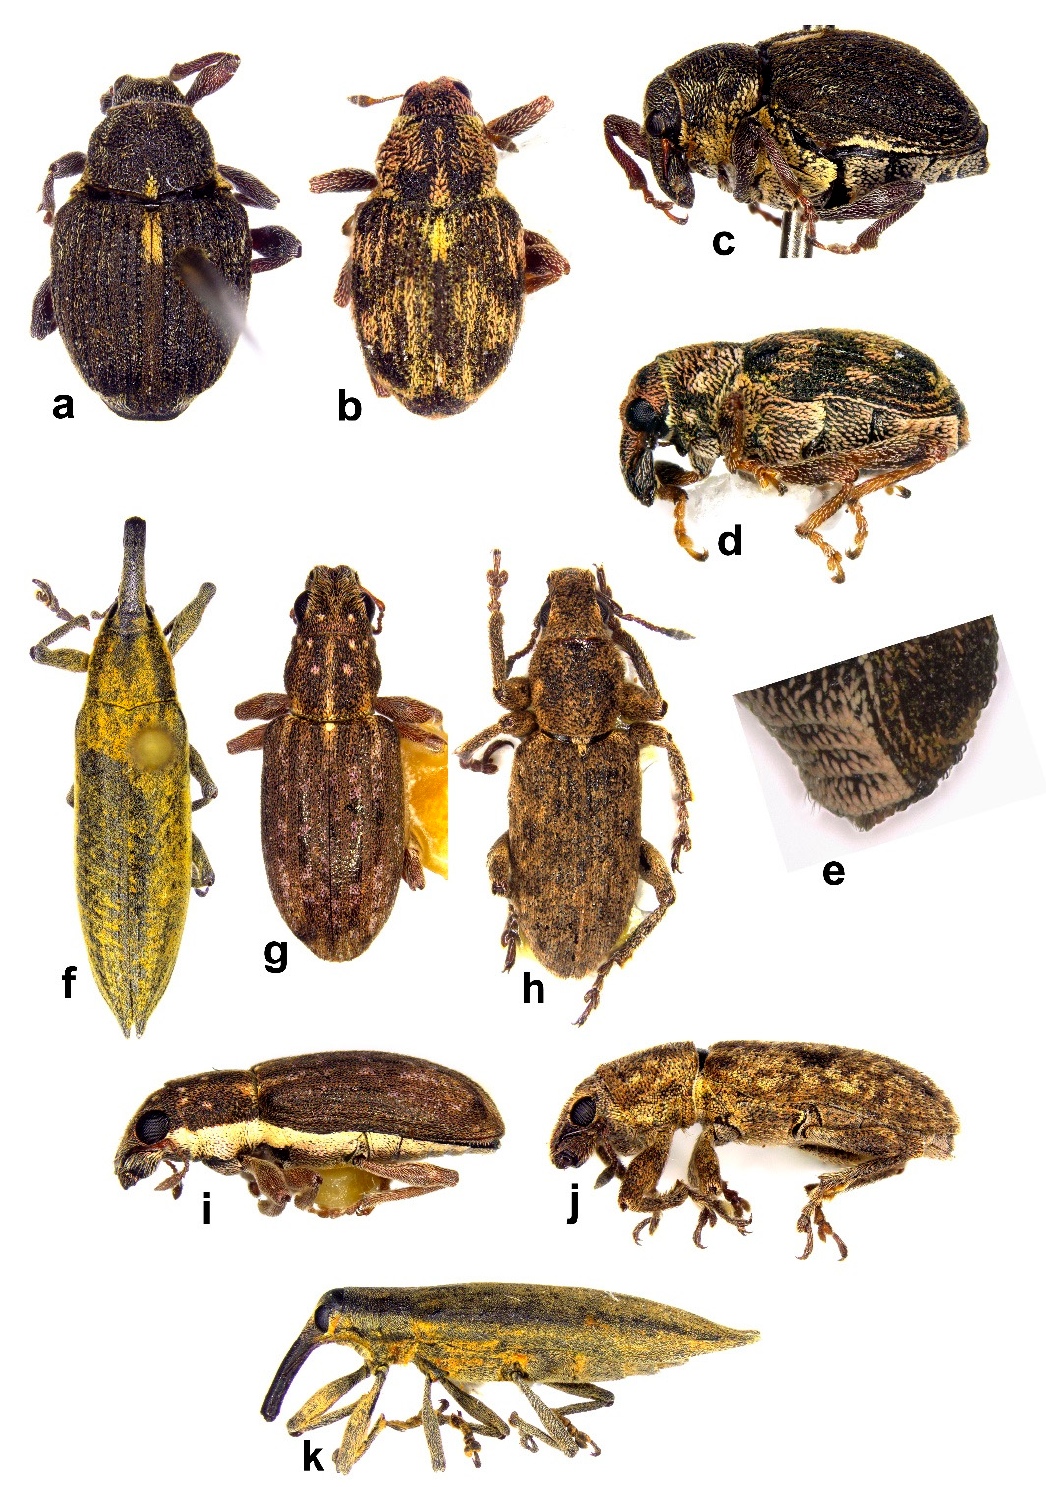
Figure 12. Habitus ( a ) Rhinoncus pericarpius , male, dorsal view; ( b ) R. perpendicularis , male, dorsal view; ( c ) R. pericarpius , male, lateral view; ( d ) R. perpendicularis , male, lateral view; ( e ) R. perpendicularis , male, abdominal sternites, lateral view; ( f ) Lixus iridis , male, dorsal view; ( g ) Sitona lividipes , male, dorsal view; ( h ) Tanymecus musculus , male, dorsal view); ( i ) S. lividipes , male, lateral view; ( j ) T. musculus , male, lateral view); ( k ) L. iridis , female, lateral view. Rhinoncus pericarpius (Linnaeus, 1758) [122] (Figures 12a,c and 13d) Material Examined: 11 exx.